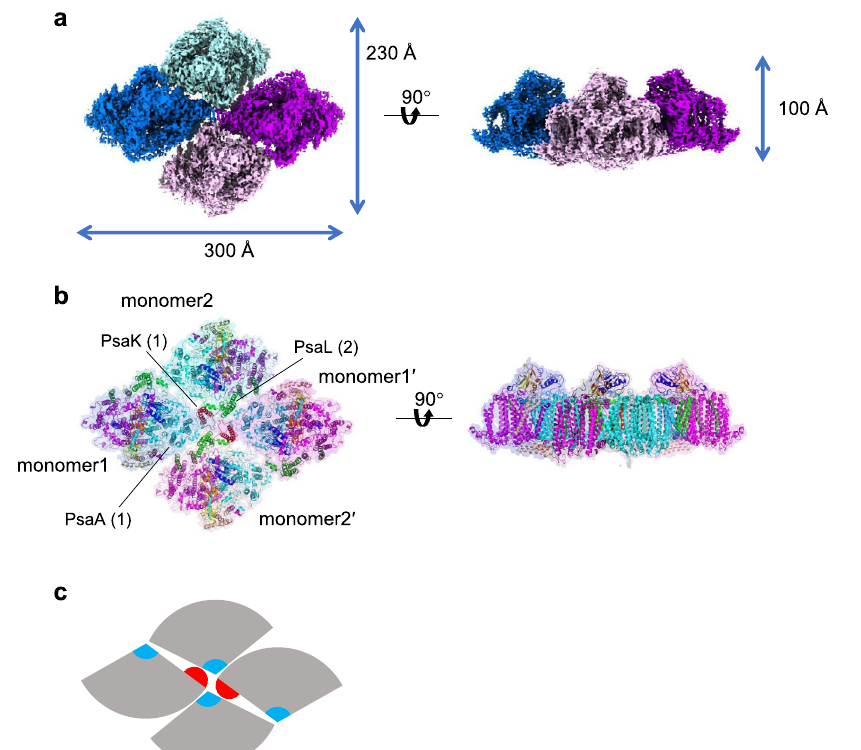
Fig. 1 Overall structure of the GraFix PSI tetramer. a 3D cryo-EM density map of the PSI tetramer viewed along the membrane normal from the stromal side (left) and its side view (right). b Structure of the PSI tetramer viewed along the membrane normal from the stromal side (left) and its side view (right). c Schematic diagram of the PSI tetramer. PsaK and PsaL are shown in red and cyan,